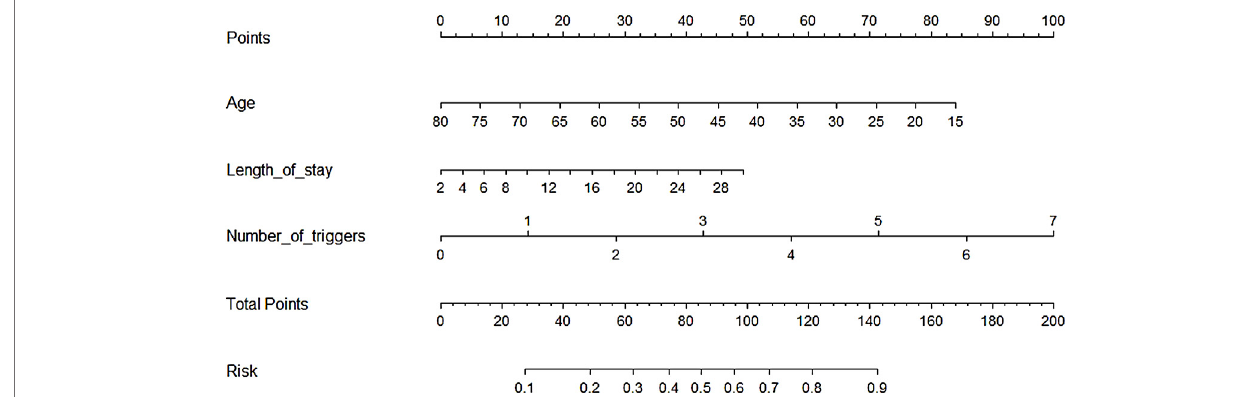
FIGURE 3 | Nomogram based on the logistic model.